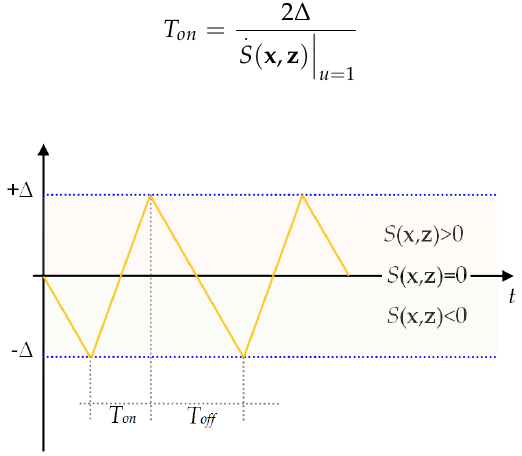
Figure 7. Qualitative time evolution of the function S ( x , z ).